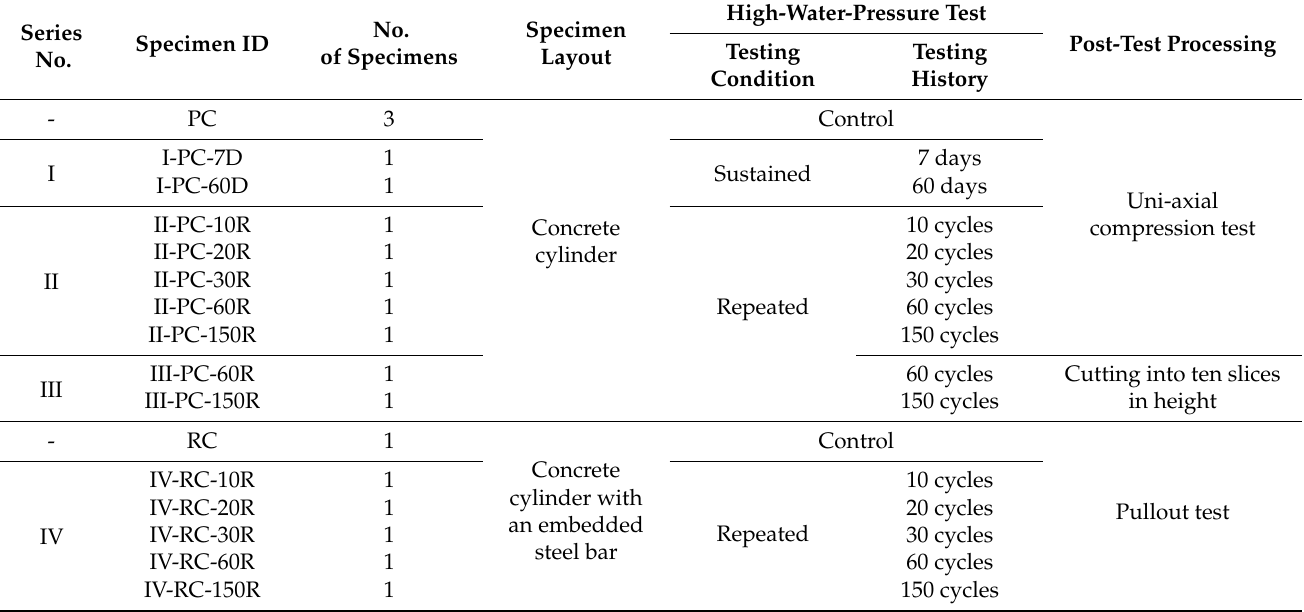
Table 3. Specifications of specimens for the high-water-pressure